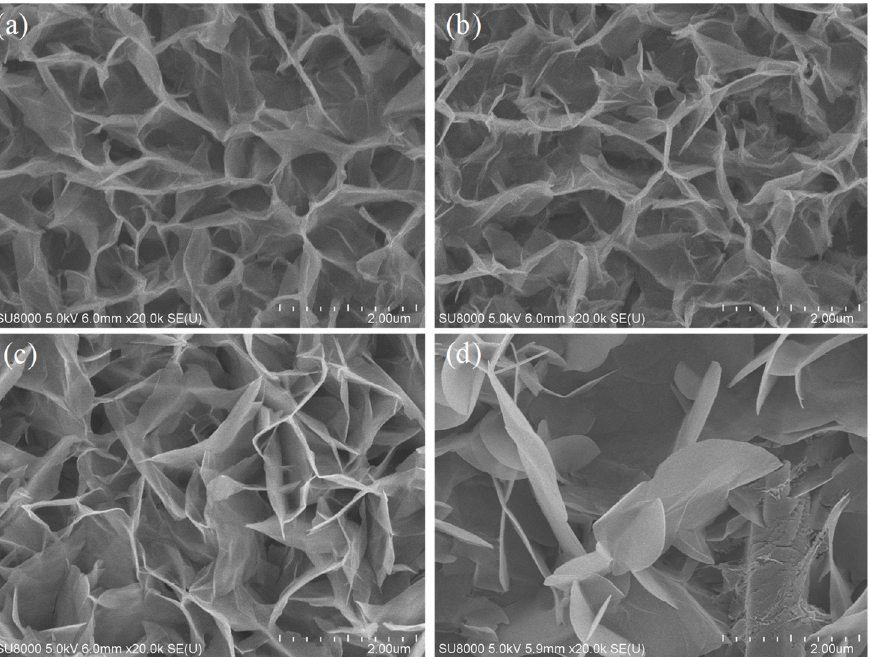
Figure 5. Comparison of ZnO nanostructure prepared on 40 nm Al AZO with different growth times: ( a ) 45 min, ( b ) 90 min, ( c ) 180 min, ( d ) 270 min.